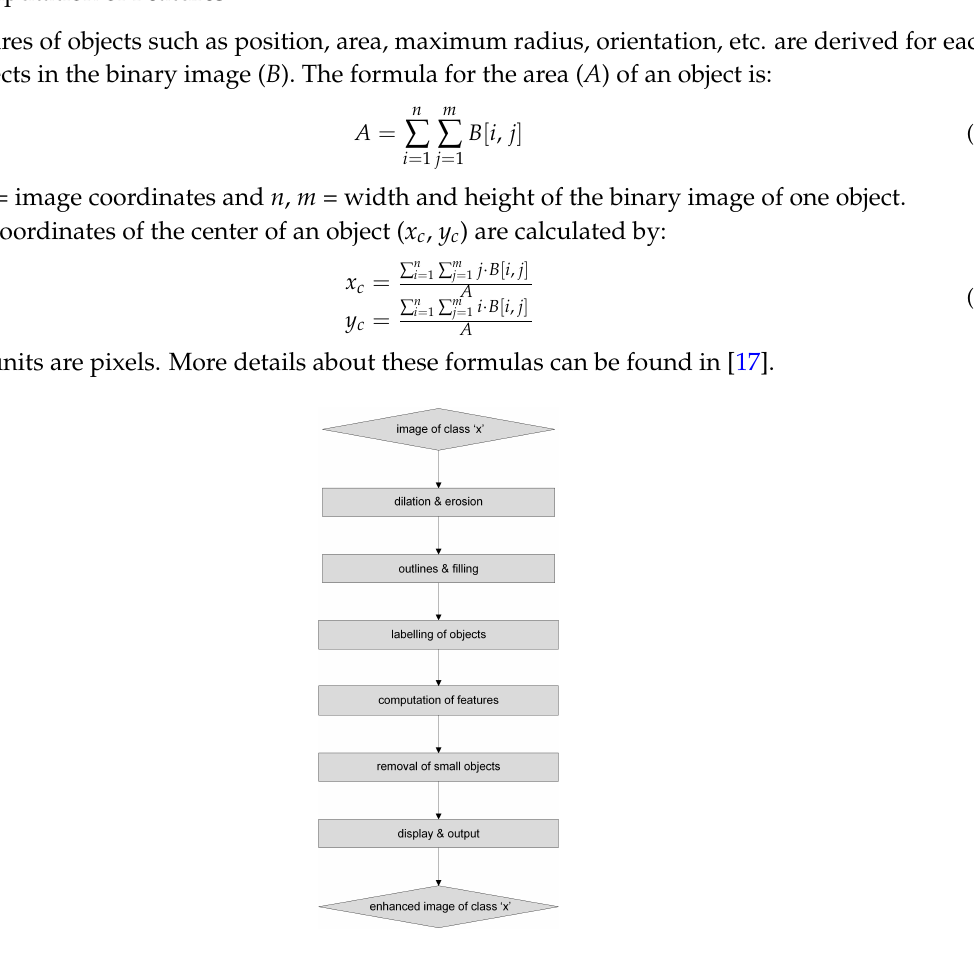
Figure 1. Steps in cartographic enhancement of land cover maps (Level 1).